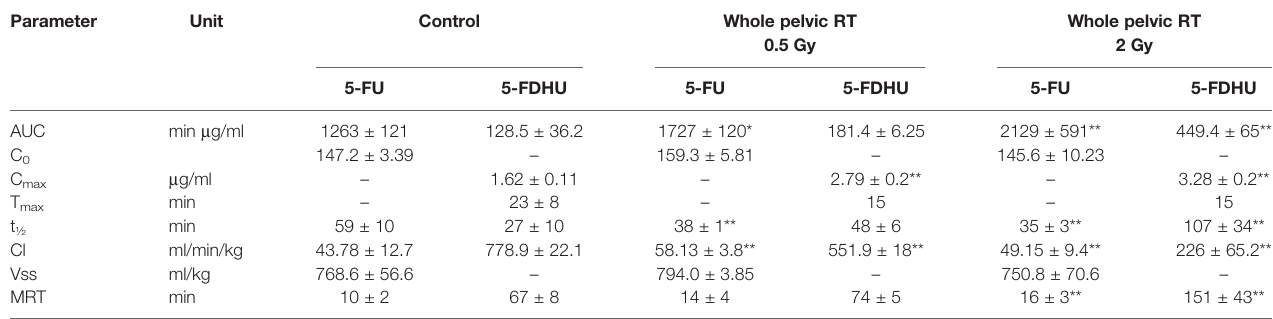
TABLE 6 | Pharmacokinetic parameters of 5-FU (100 mg/kg, i.v.) and 5-FDHU from rat bile.